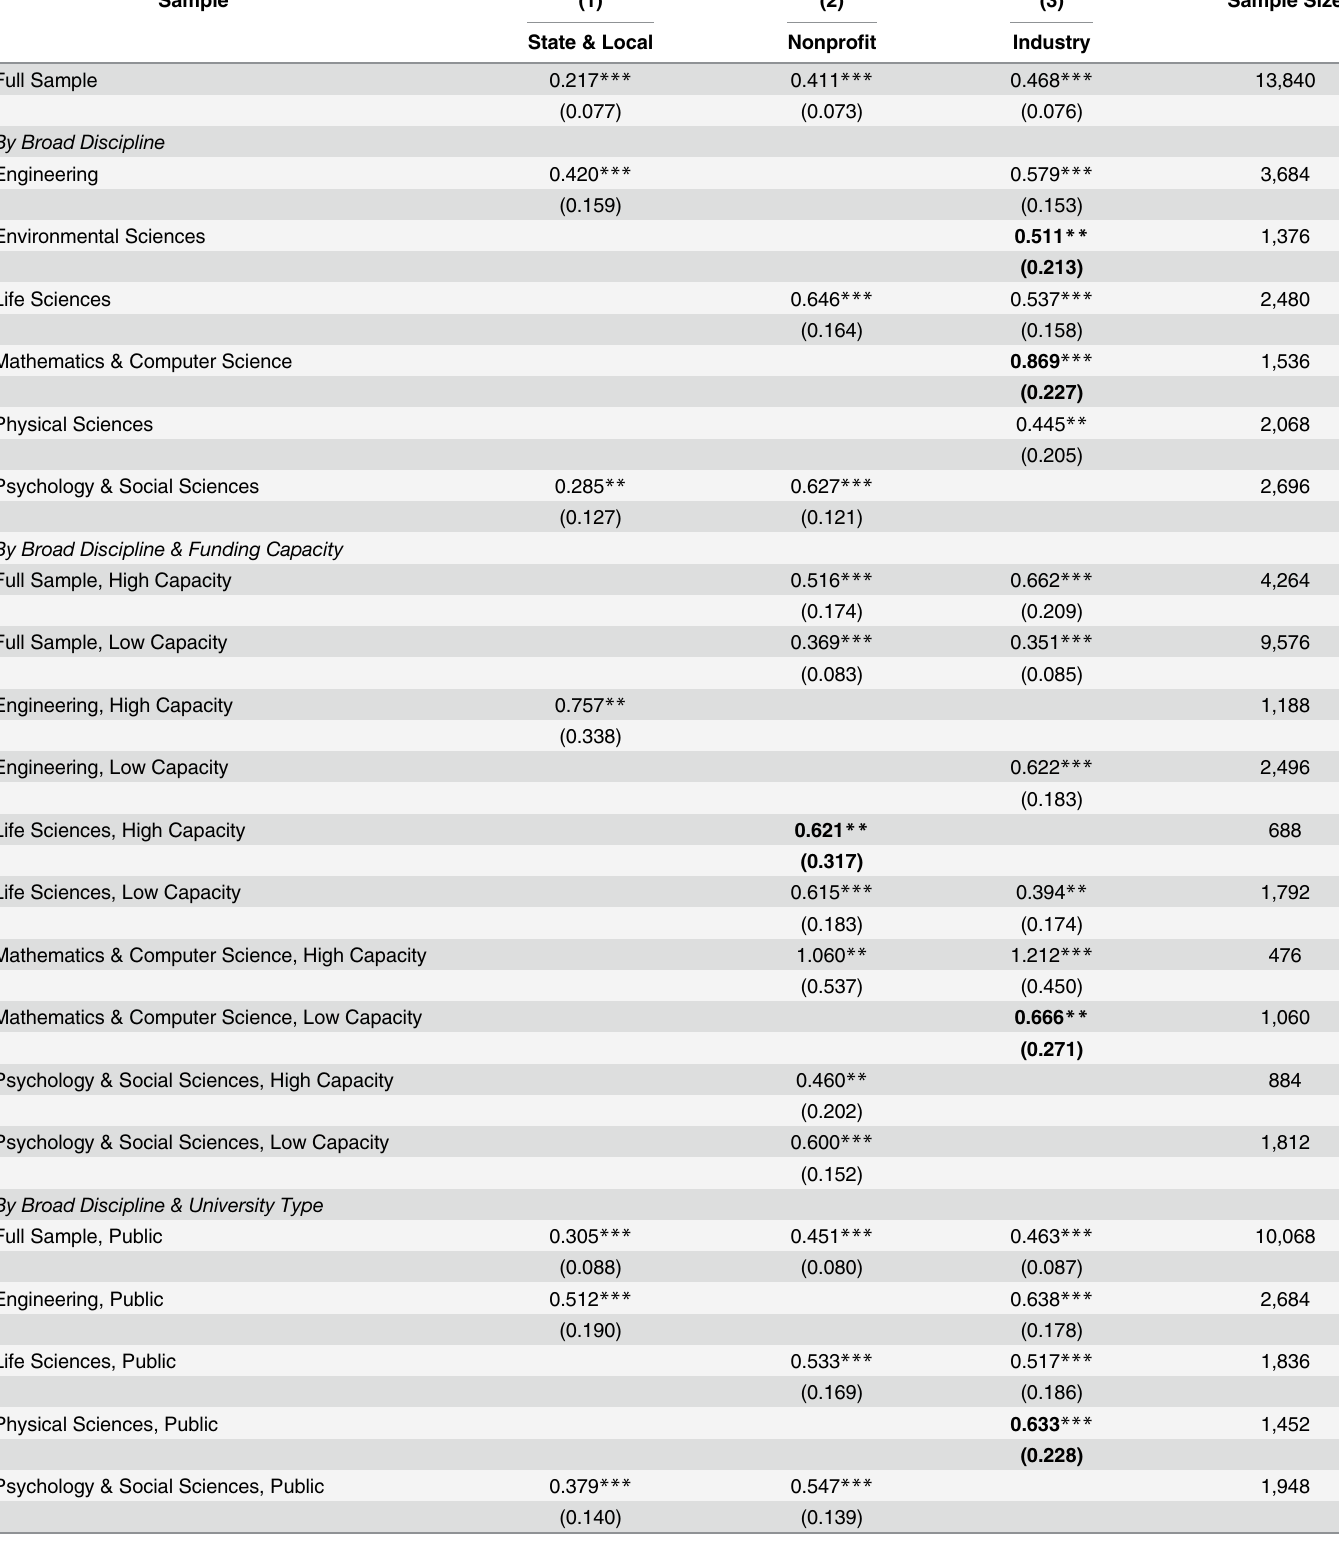
Table 8. Comparison of Significant (Eq 1) and Robust Federal Funding Elasticities by